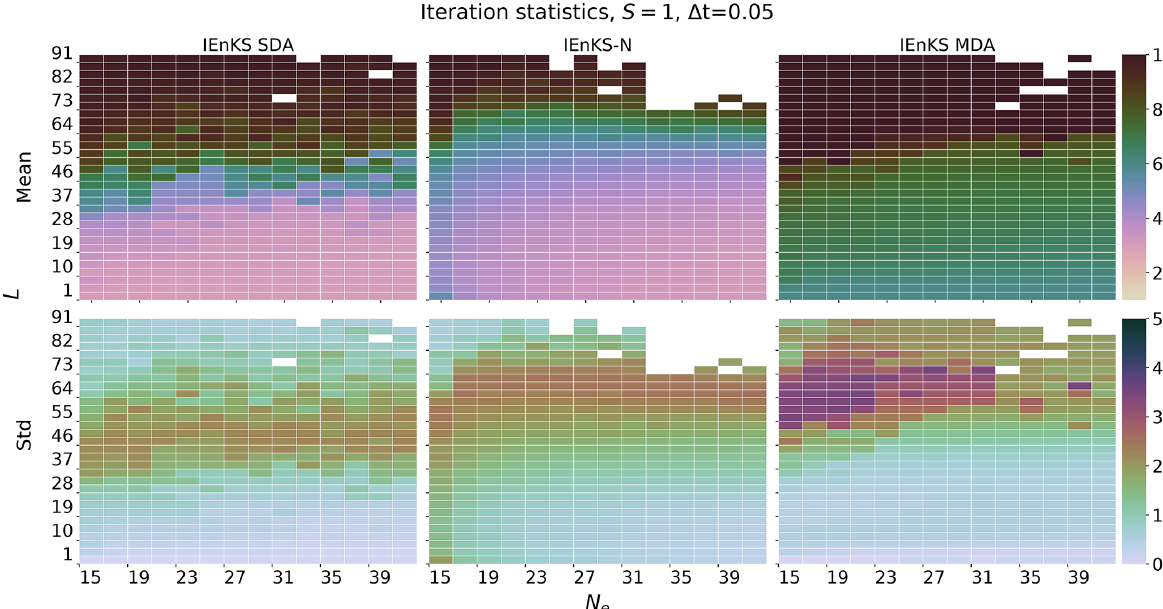
Figure 14. Iterations per cycle versus lag L on the vertical axis and ensemble size N e on the horizontal axis. The mean (top panel) and standard deviation (bottom panel) of the iterations used per cycle from simulations, generating Figs. 6, 8, and 10, are